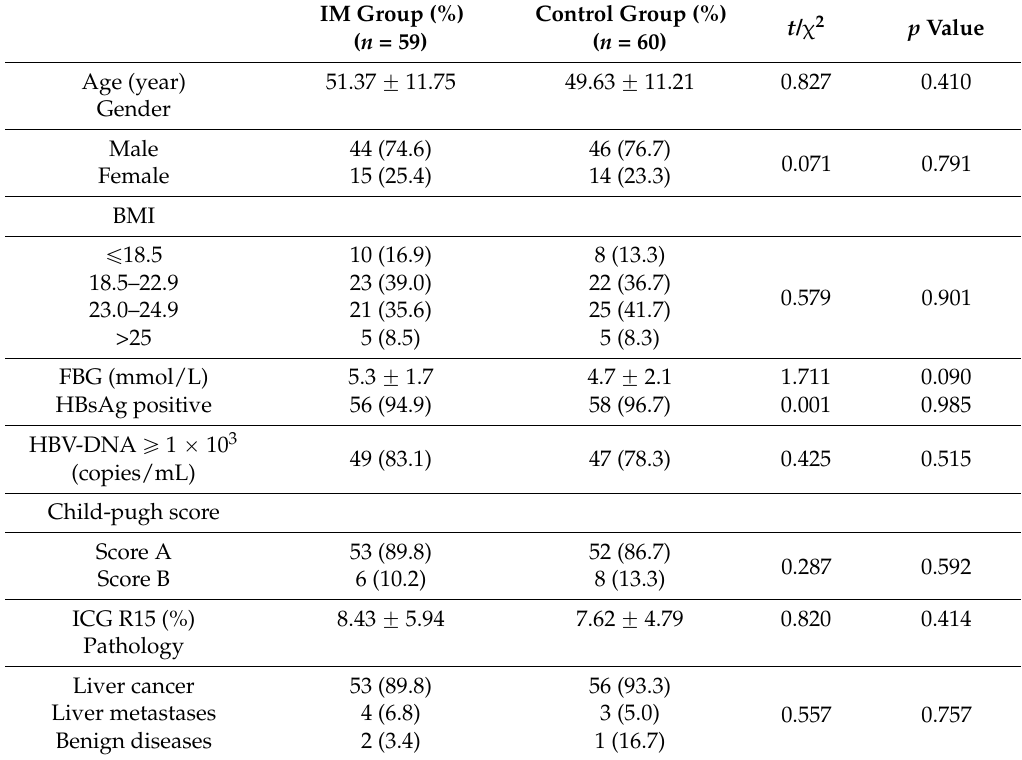
Table 1. Baseline characteristics of the two